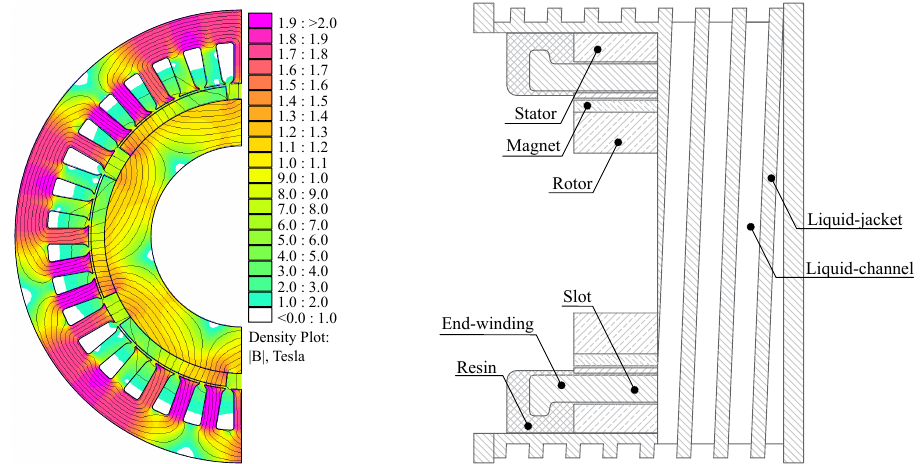
Figure 10. Left: EM flux density plot and flux lines obtain by means of FEA. Simulation of the maximum overload working condition. Right: EM structure including encapsulated end-winding in the resin potting and the housing with a liquid-cooling